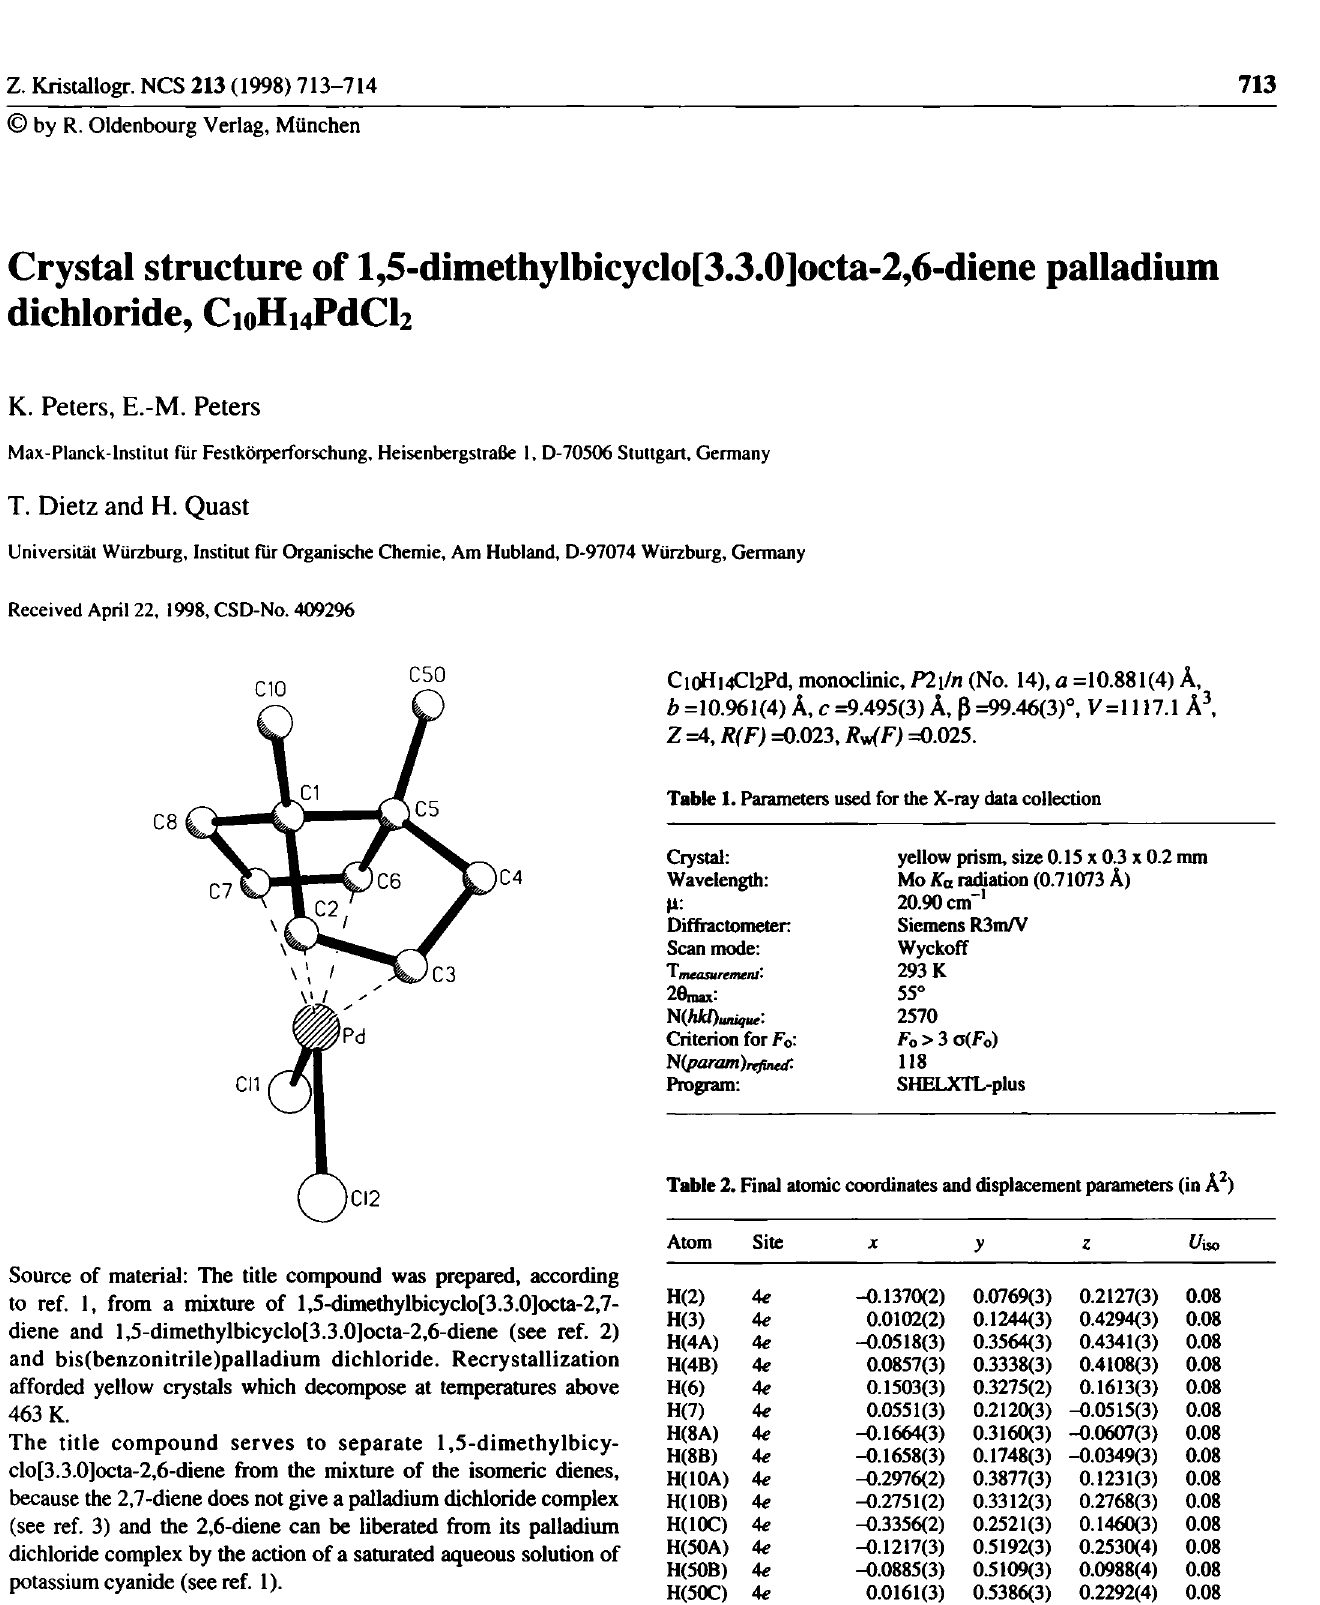
Table 3. Final atomic coordinates and displacement parameters (in Л^)